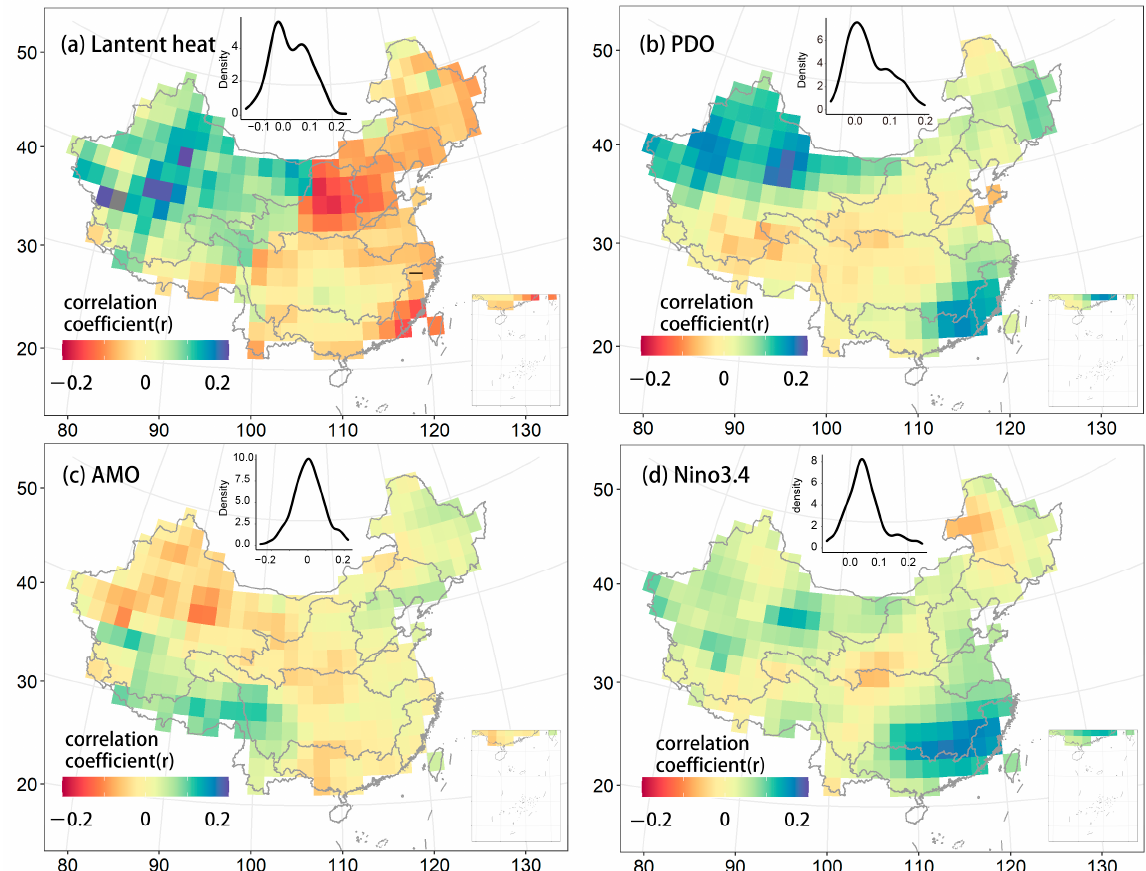
Figure 5. Spatial distribution of SPEI-1 response to LHF, PDO, AMO and Nino3.4. When analyzing the relationship between meteorological drought and a climate index at only a single scale, an intrinsic relationship often cannot be found; thus, in this paper, we analyzed the spatial relationships between the SPEI-12 and the LHF, PDO, AMO and Nino3.4 indices (Figure 6). The spatial distribution of the correlation between the latent heat flux and SPEI-12 was quite different from the spatial distribution of the SPEI-1 index itself. The areas where the SPEI-12 and latent heat flux were negatively correlated are mainly concentrated in the southeastern coastal watershed, the Pearl River watershed and the middle and lower reaches of the Yangtze River. The correlation coefficient in these